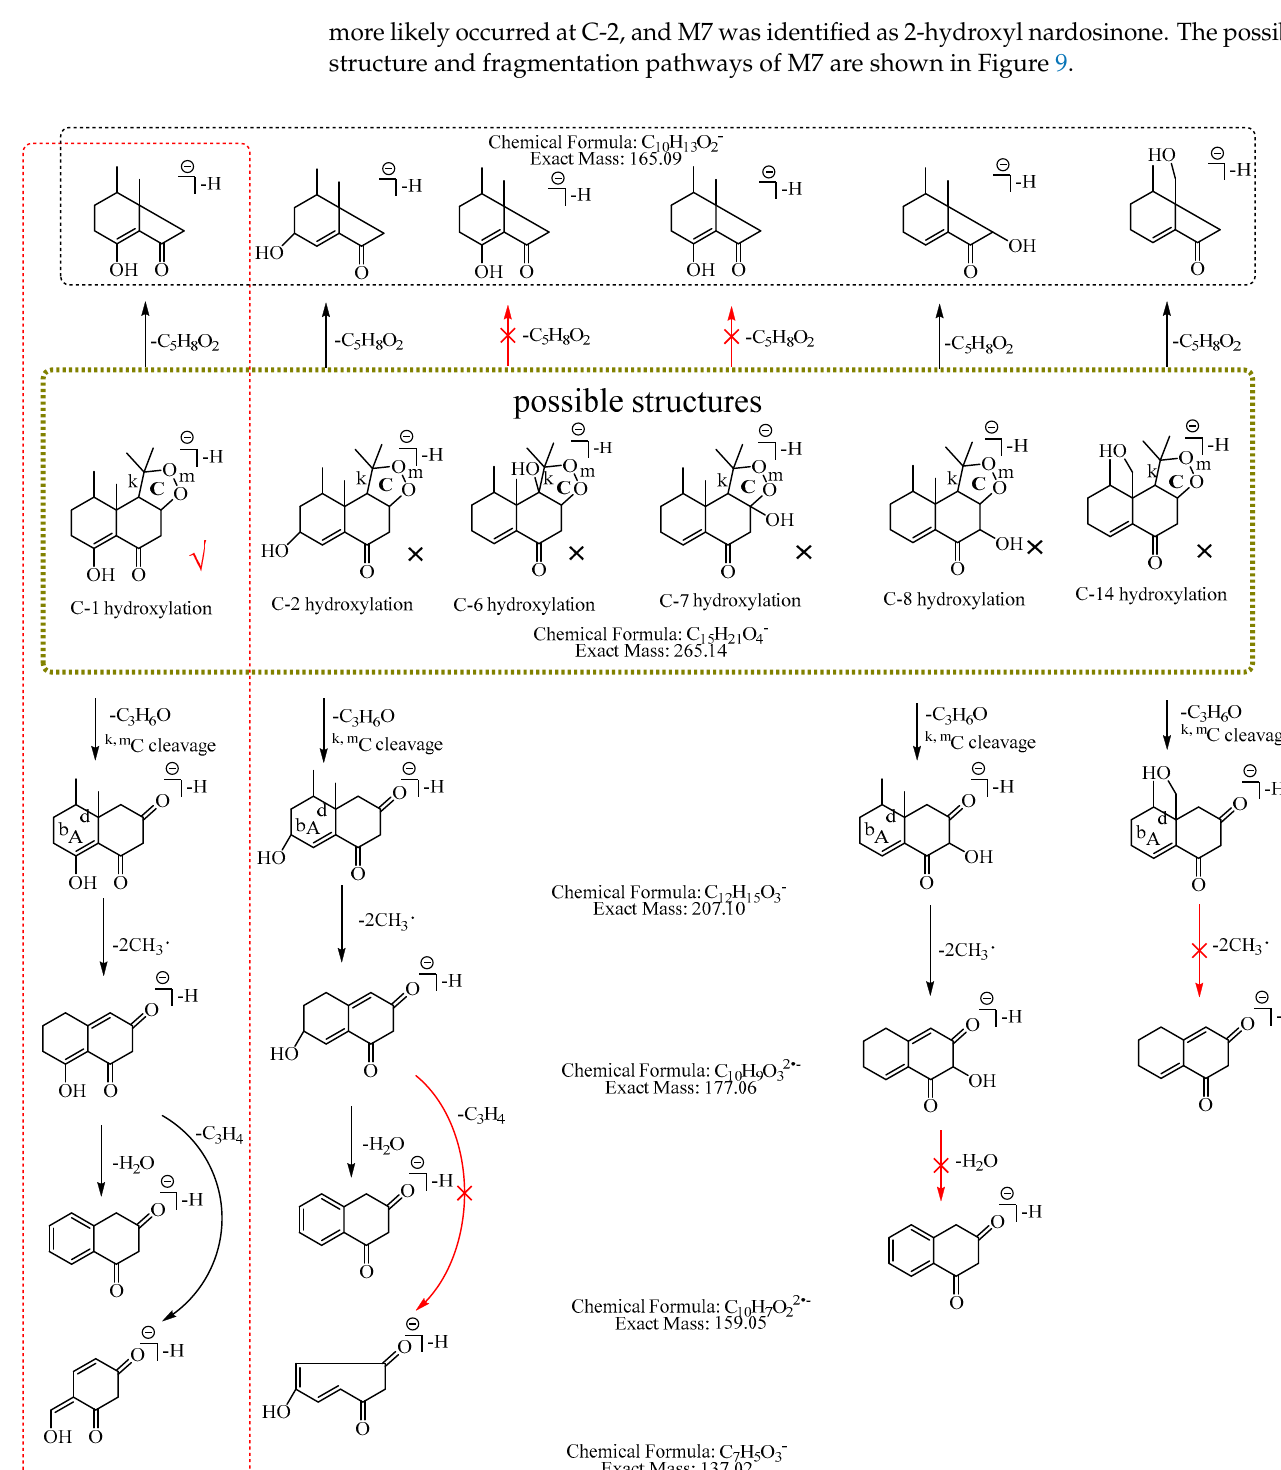
Figure 8. The proposed fragmentation pathways of M6 (1-hydroxyl nardosinone). “ √ ” represents the possible structure. “×” represents the impossible structure. The olive rim represents the possible structures; C represents the hexatomic ring. The red rim represents the most possible fragmentation pathway.